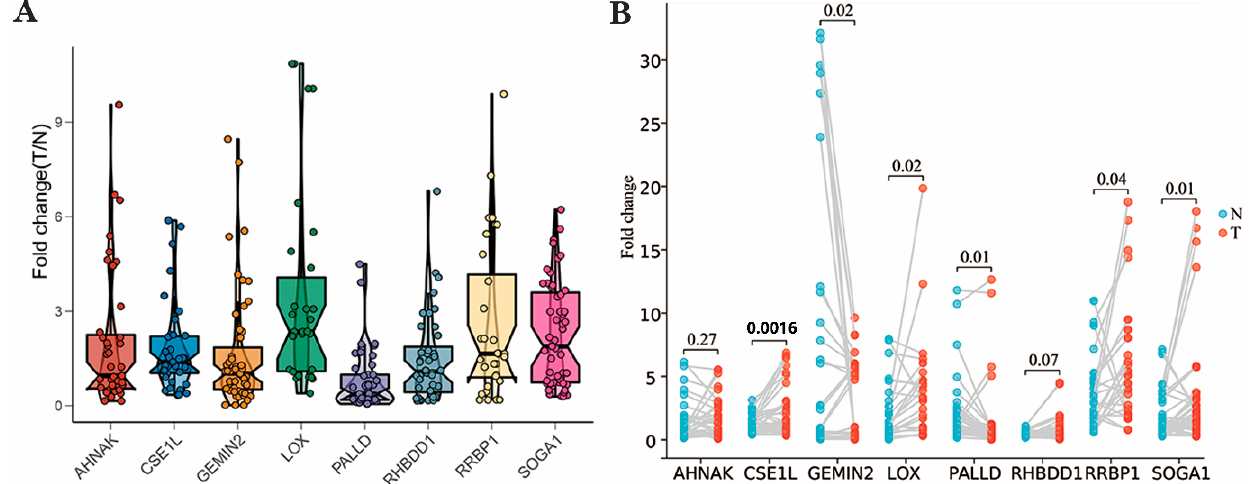
Figure 6. Expression levels of the potential biomarker genes. ( A ) Fold change in expression of potential biomarker genes AHNAK, CSE1L, GEMIN2, LOX, PALLD, RHBDD1, RRBP1 and SOGA1. The statistical difference was measured with Kruskal–Wallis test ( p < 0.00001). ( B ) Fold change in expression of potential biomarker genes of each pair of tumor and para-carcinoma tissue. The statistical difference was measured with the paired Students’ t test.